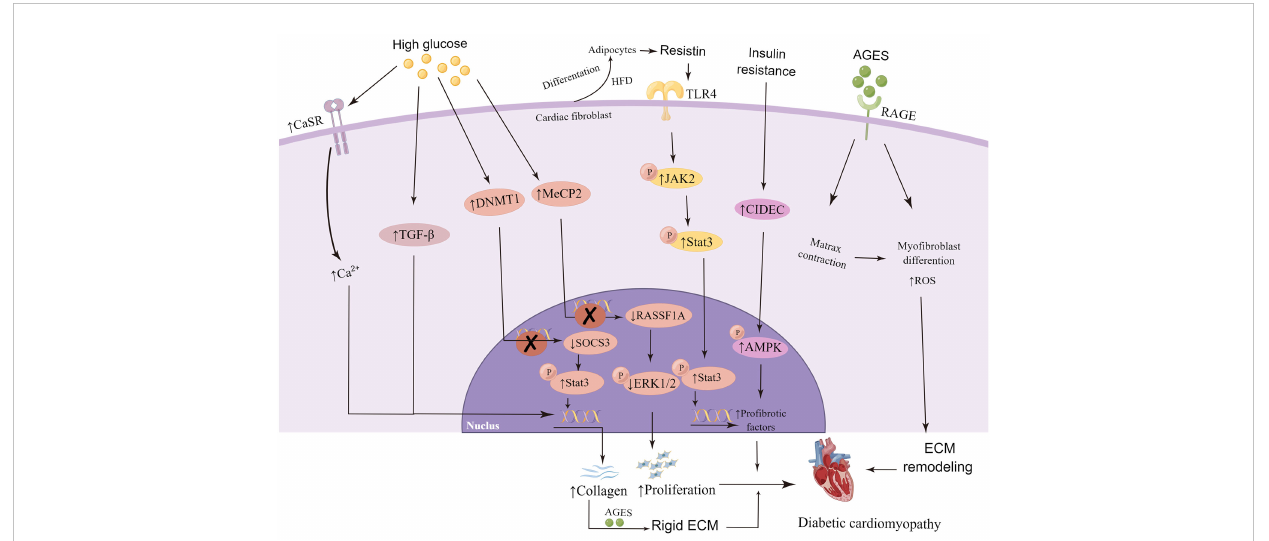
FIGURE 3 High glucose, abnormal lipid metabolism and advanced glycation end products (AGES) affects cardiac fi broblasts in the development of diabetic cardiomyopathy. Continuous hyperglycemia stimulation up-regulates the expression of calcium-sensitive receptor (CaSR), transforming growth factor-beta1 (TGF- b ), DNA methyltransferase 1 (DNMT1) and Methyl CpG binding protein 2 (MeCP2) in cardiac fi broblast, and result in the increase of collagen secretion, deposition or proliferation, eventually promote the development of DCM. Resistin released by adipocytes increased expression